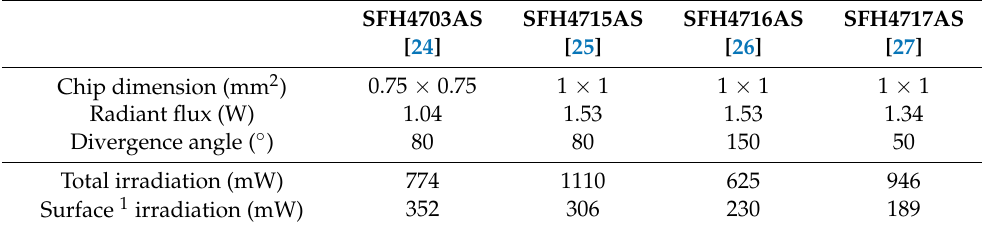
Table 1. Commercial LED parameters and their simulated irradiation